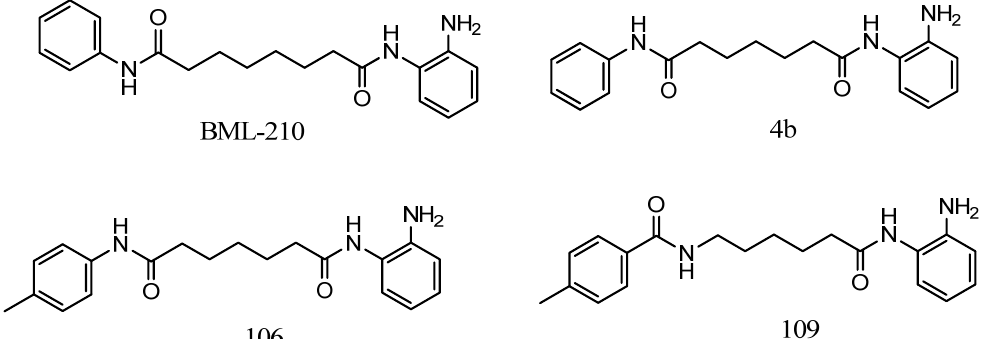
Figure1. Structures of HDAC inhibitors